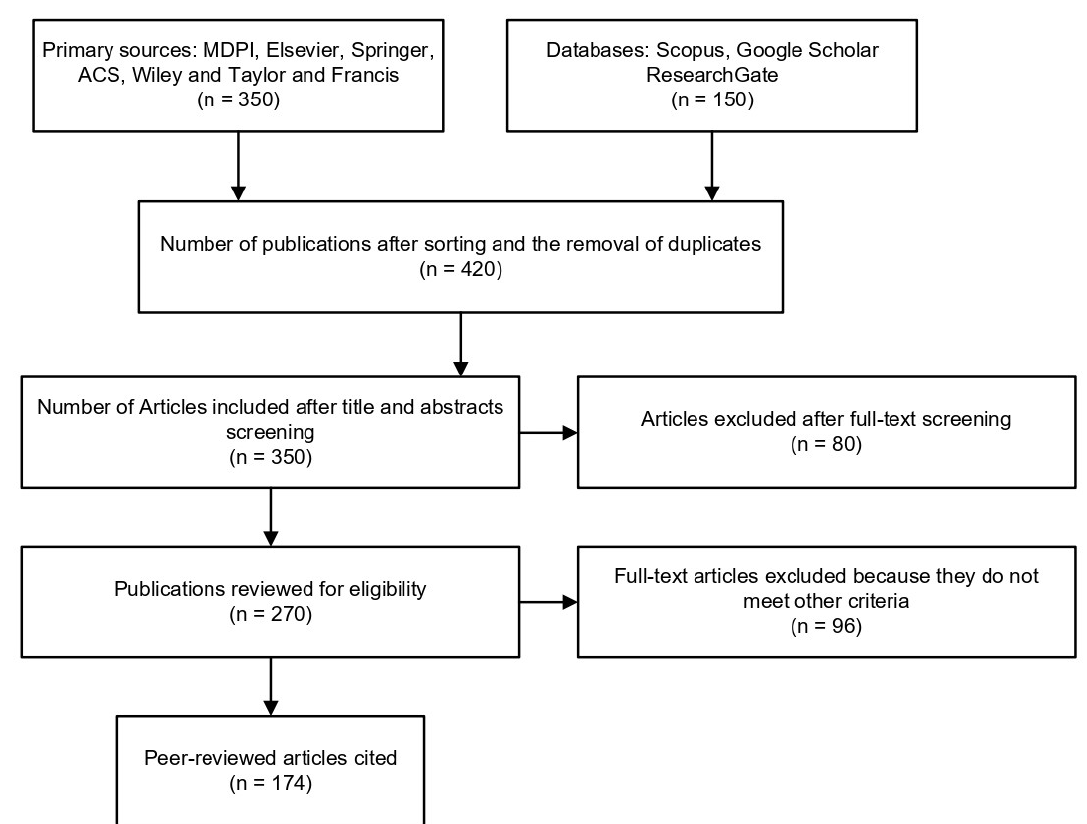
Figure 2. PRISMA